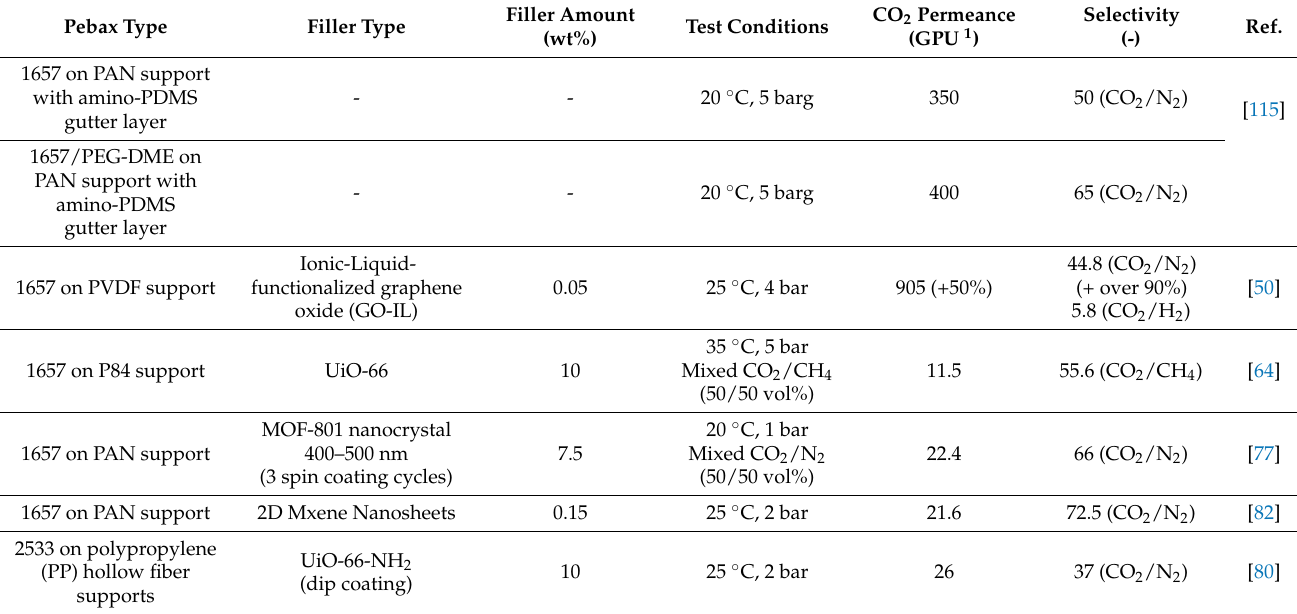
Table 12. Permeation properties of selected Pebax-based thin-film nanocomposite